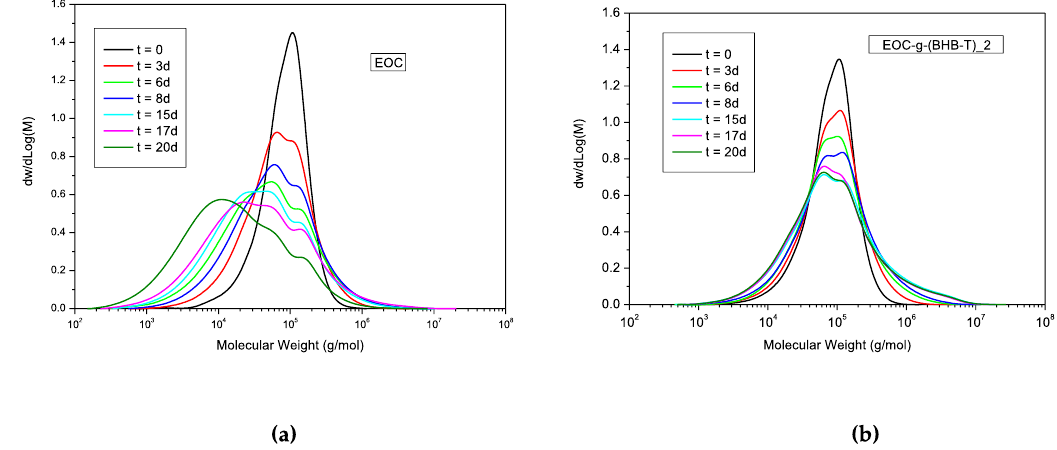
Figure 3. Differential molecular weight distribution (MWD) of EOC ( a ) and EOC- g -(BHB-T)_2 ( b ) before and after different UV irradiation times.